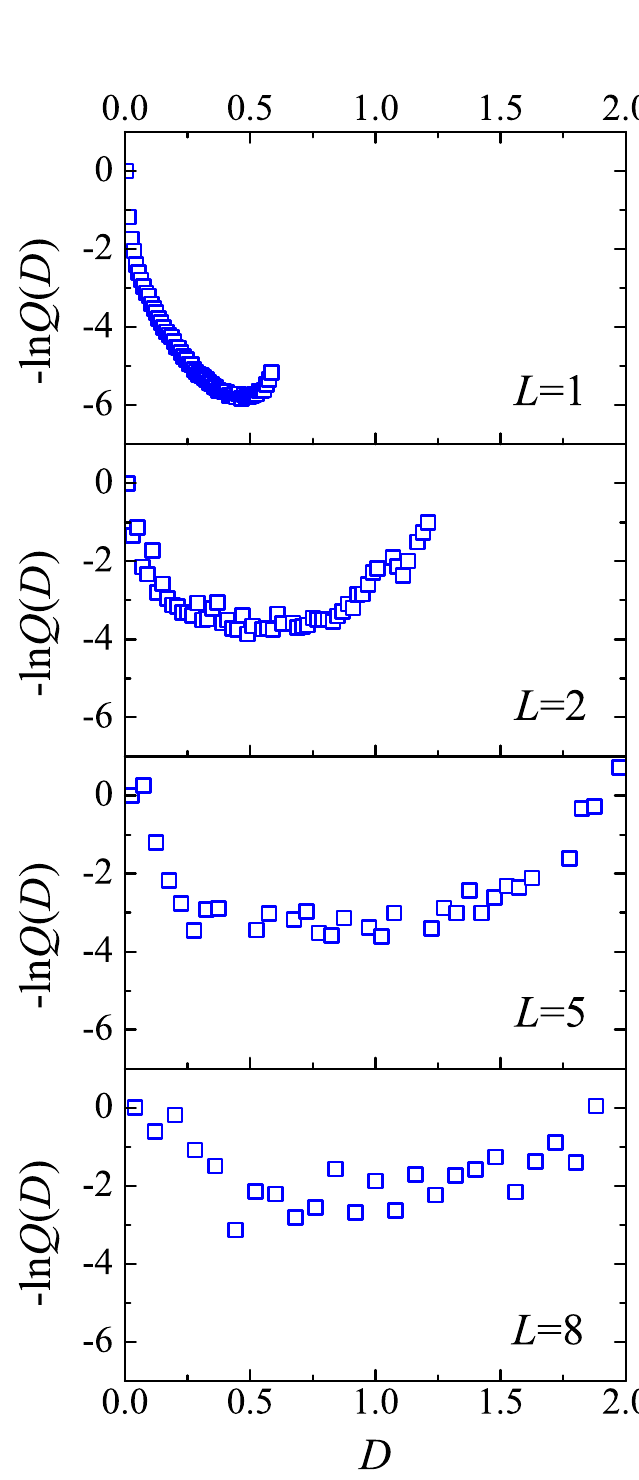
Figure 8. The value of term − ln Q ( D ) versus the distance between the two injection points of loops for loop length L = 1,2,5,8. The absolute values of − ln Q ( D ) , and the relative value between different curves, are both meaningless. − ln Q ( D = 0 ) of each curve is chosen to be